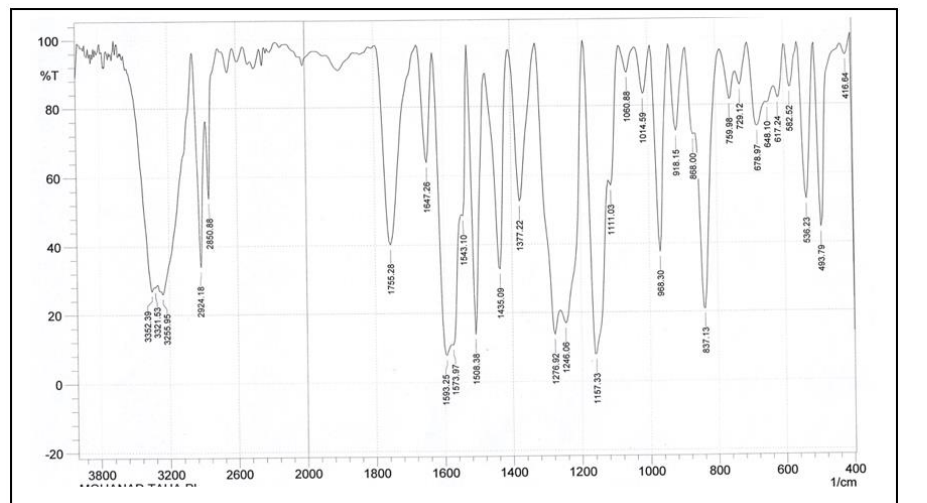
Fig. 1. FT-IR spectrum of PA